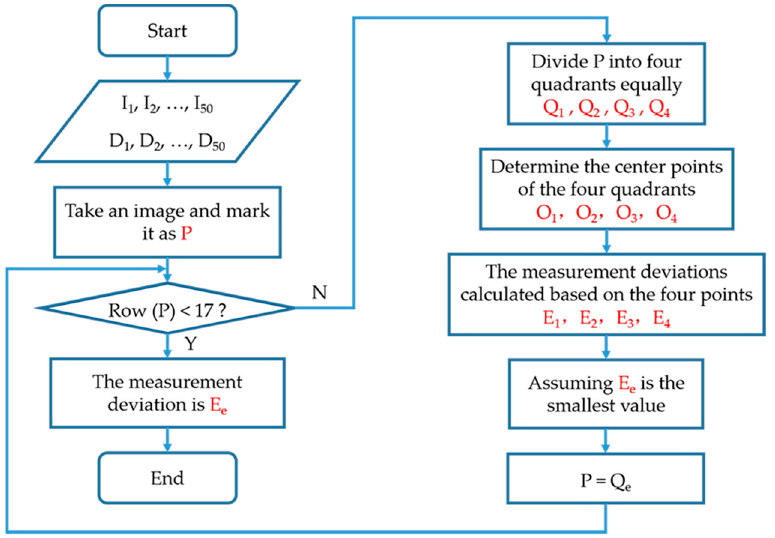
Figure 15. The measurement locations alignment method based on successive approximation.